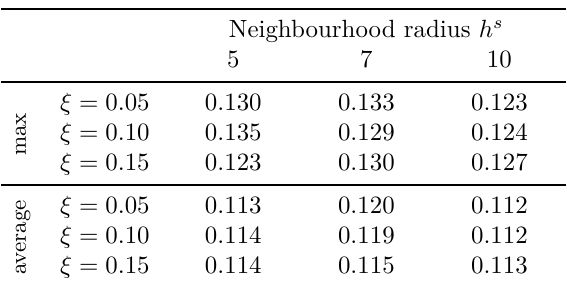
Table 7. Values of the local heterogeneity error ε D , depending on the magnitude of artificially introduce noise ξ , neighbourhood radius h s , and the type of pooling layer used (max or average). For comparison, the value of ε D for the reference image is